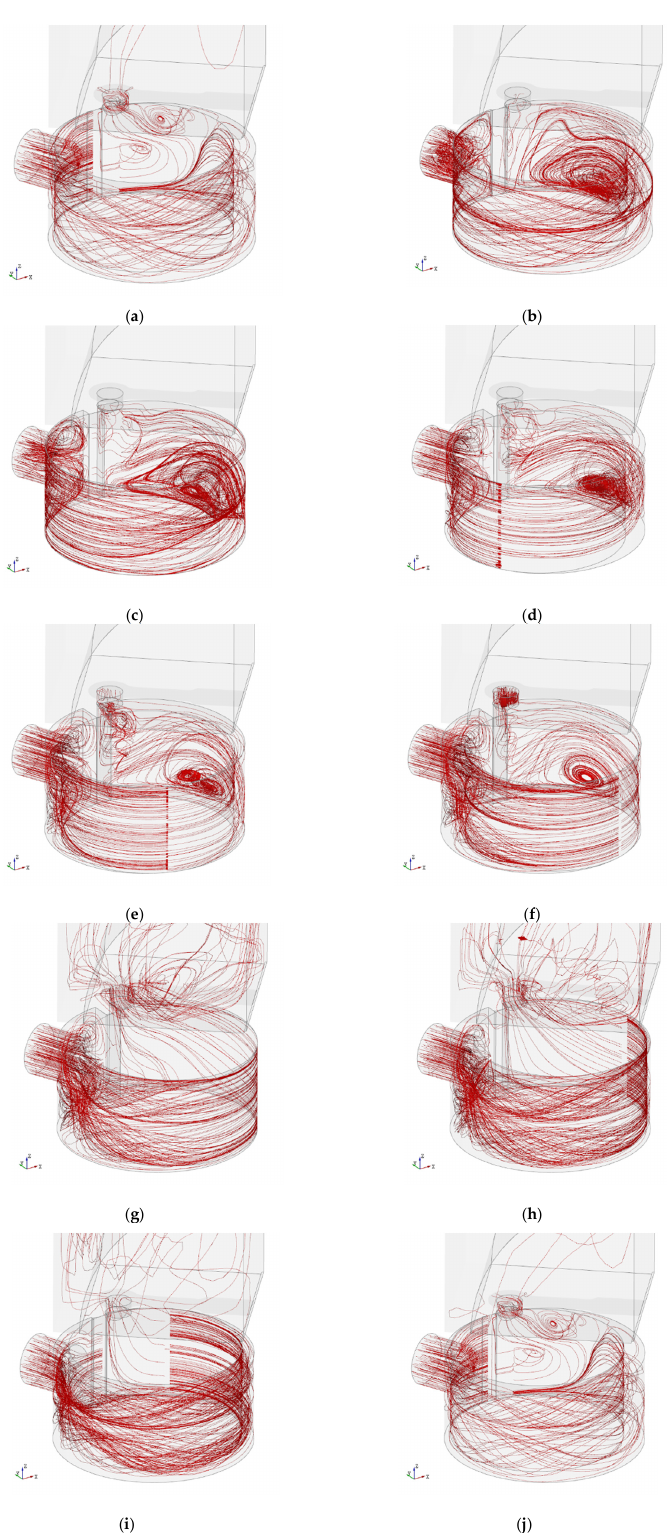
Figure 10. Streamlines at different rotation angles of piston: ( a ) 0°, ( b ) 40°, ( c ) 80°, ( d ) 120°, ( e ) 160°, ( f ) 200°, ( g ) 240°, (h) 280°, ( i ) 320°, ( j ) 360°.